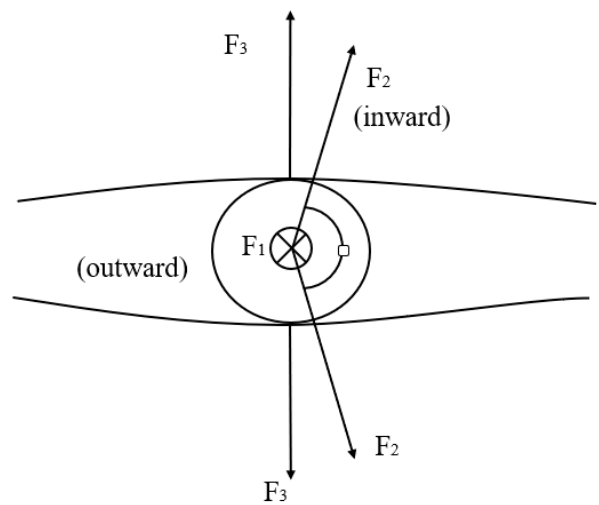
Figure 4. Force decomposition of pulverized coal.